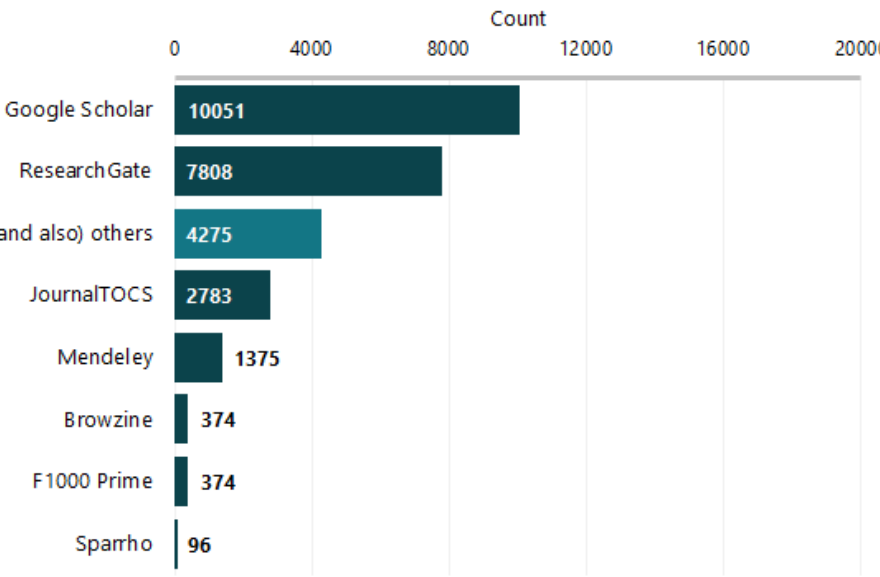
Figure 4: Fragment from the survey results demonstrating digital tools used to Get alerts (https: